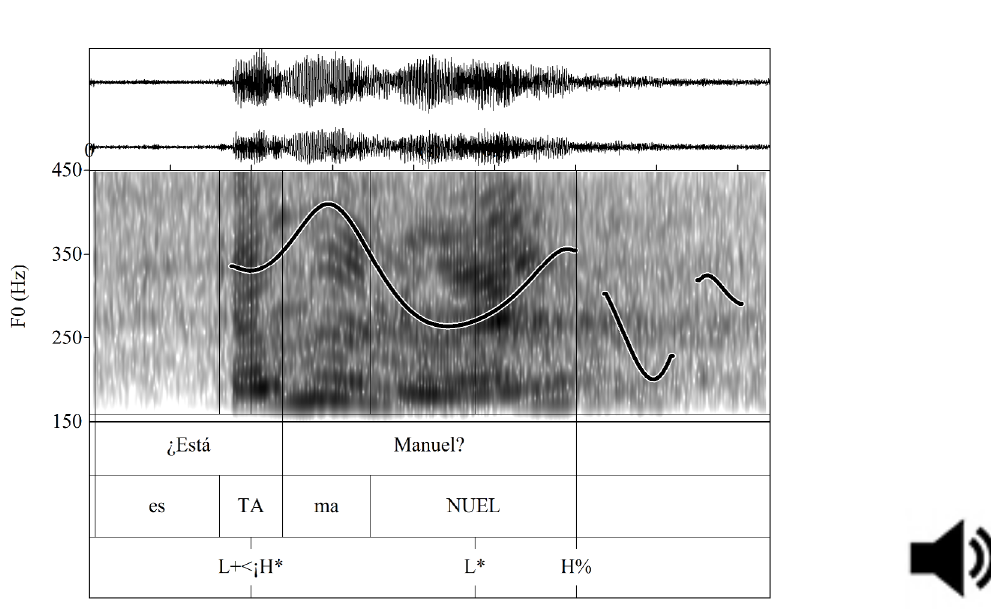
Figure 9 (Participant 12): Waveform and F0 trace for the info seeking yes-no question ¿ Está Manuel? ‘Is Manuel there?’ produ- ced with L+<H* in pre-nuclear position and L* in nuclear position followed by an H% boundary